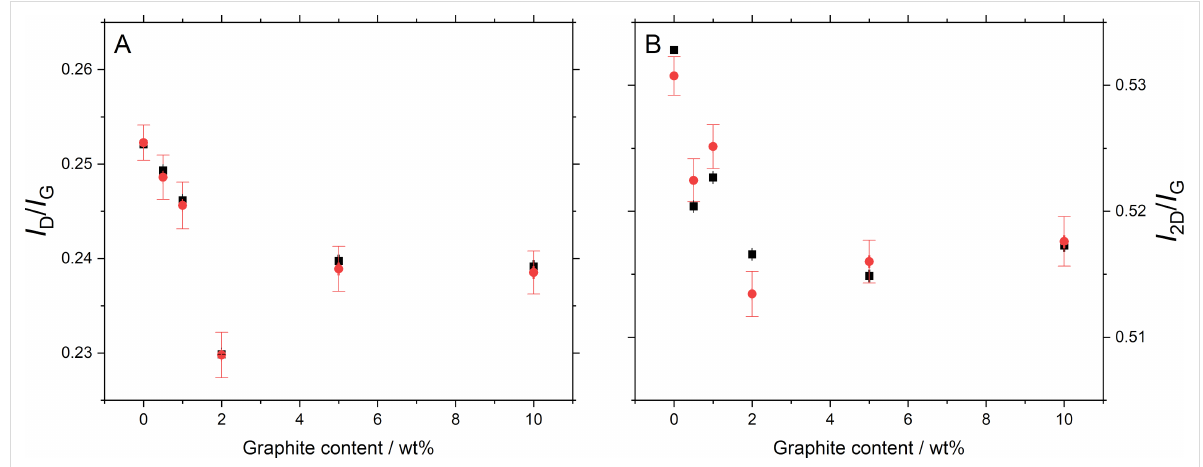
Figure 3: Fitted peak intensity ratios. (A) I D / I G and (B) I 2D / I G , showing the values from the averaged spectra (black) with the combined standard error of the fit, and the mean value of the fits across each map (red) with the standard error of the